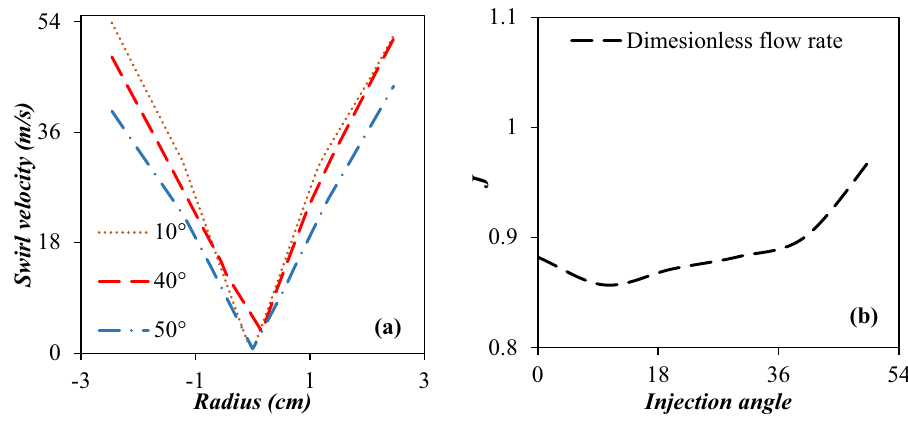
Figure 10. Swirl velocity (at y (length) = 0.4 m) ( a ) and mass flow ratio ( b ) rate for various injection